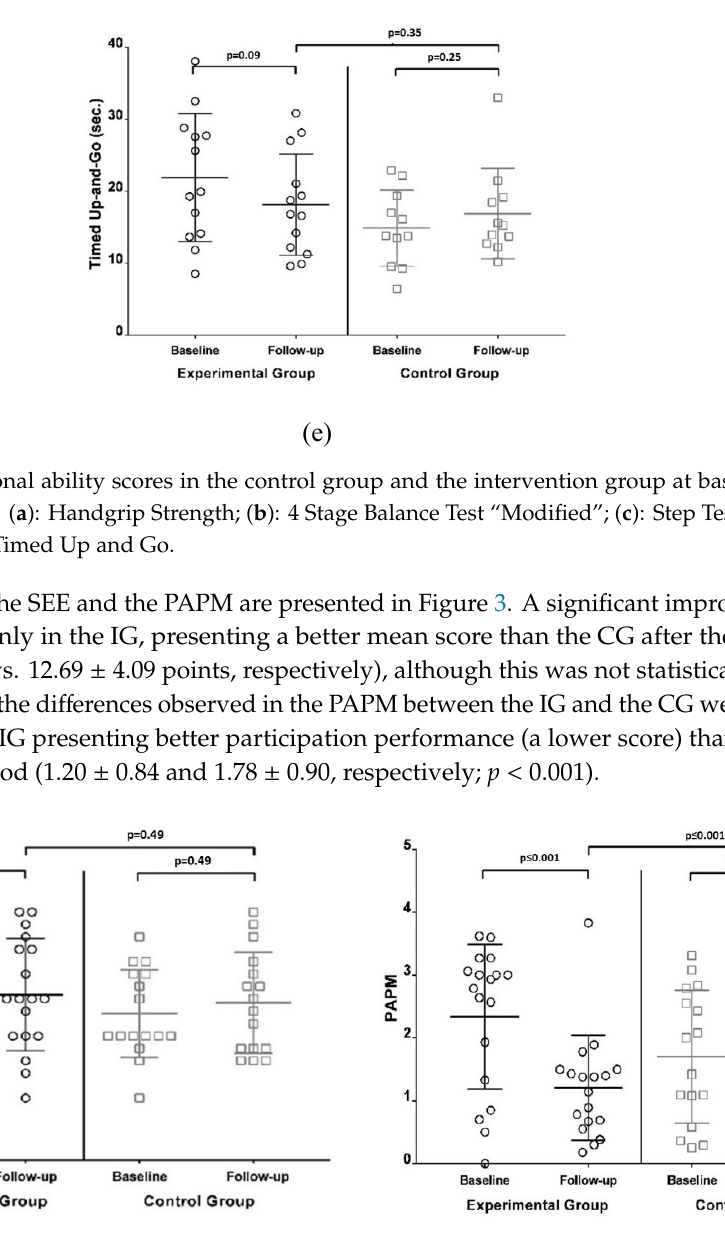
Figure 2. ( a ): Self ‐ Efficacy for exercise and ( b ): social participation scores in the control group and the intervention group at baseline and post intervention. PAPM: Activities and Participation Profile related to Mobility